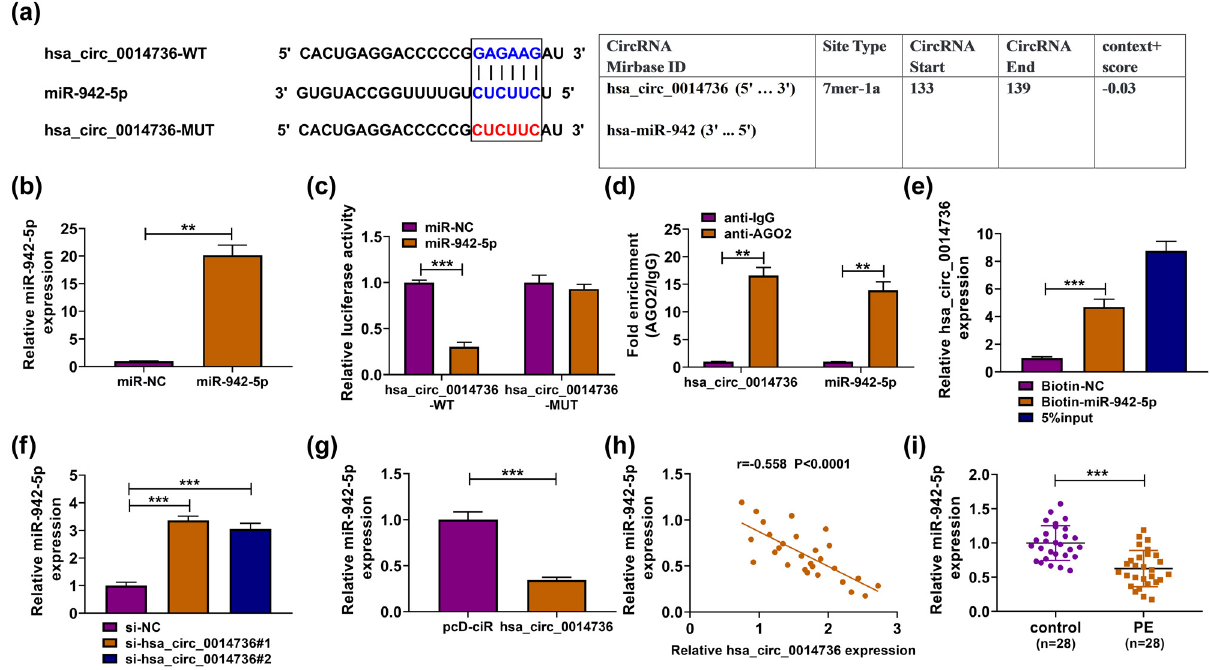
Figure 3: circ_0014736 interacted with miR - 942 - 5p. ( a ) Binding sites of circ_0014736 for miR - 942 - 5p. ( b ) E ffi ciency of miR - 942 - 5p over - expression was determined by qRT - PCR in HTR - 8/SVneo cells. ( c – e ) Dual - luciferase reporter, RIP, and RNA pull - down assays were used to identify the interaction of circ_0014736 and miR - 942 - 5p. ( f and g ) E ff ects of circ_0014736 knockdown and overexpression on miR - 942 - 5p expression were analyzed by qRT - PCR in HTR - 8/SVneo cells. ( h ) Correlation between circ_0014736 and miR - 942 - 5p expression was analyzed by Spearman correlation analysis in PE placenta tissues. ( i ) MiR - 942 - 5p expression was determined by qRT - PCR in PE placenta tissues ( N = 28 ) and normal placenta tissues ( N = 28 ) . ** P < 0.01 and *** P < 0.001. Three independent duplicate tests were performed in ( c – g )